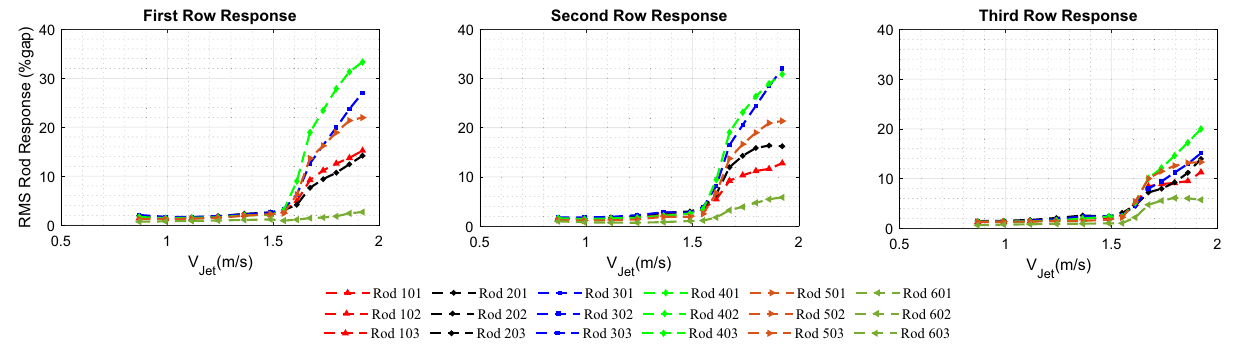
Figure 9. Rod bundle vibrations using 10 fins shark-inspired